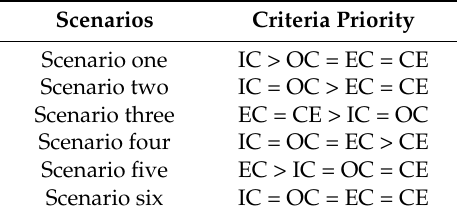
Table 7. Scenarios setting for sensitivity analysis.